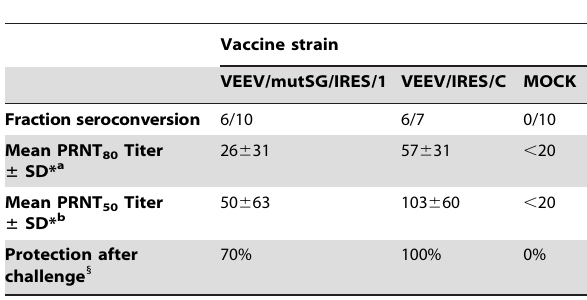
Table 2. Seroconversion of infant CD1